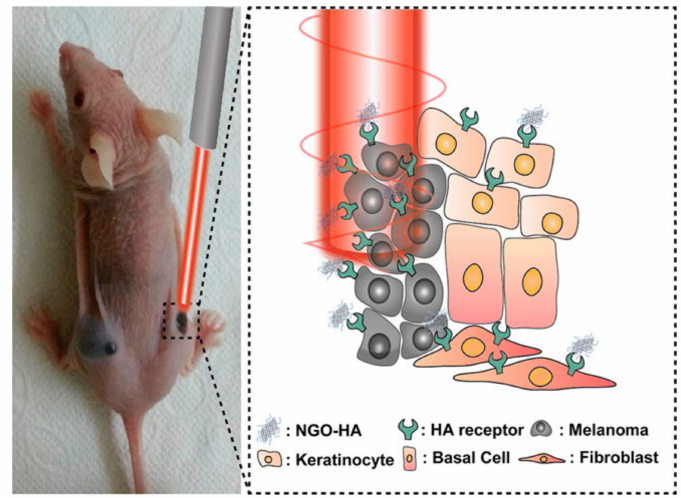
Figure 3. Use of NGO-HA to target HA receptors for photothermal ablation using a near-infrared (NIR) laser. Reprinted with permission from Ref. [33]. Copyright 2014 American Chemical Society.